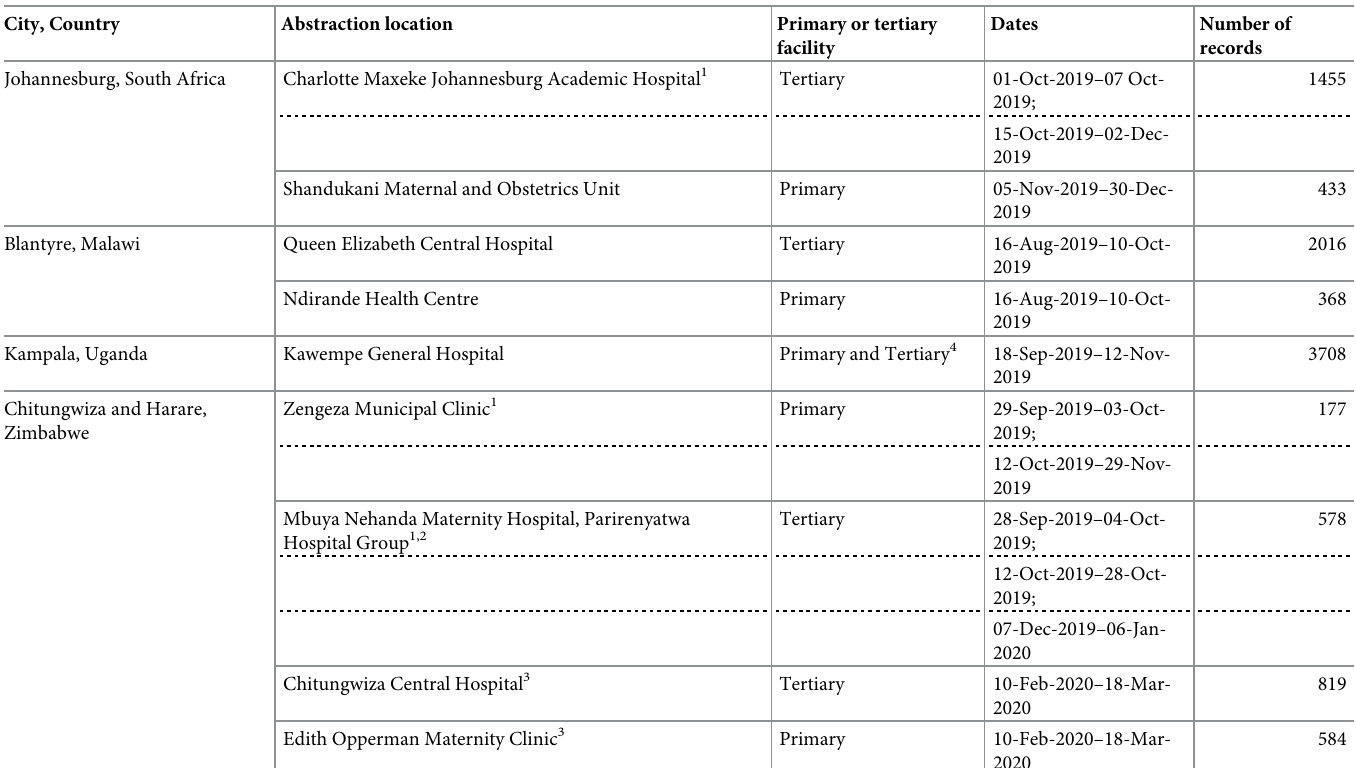
Table 1. Data abstraction locations and dates by